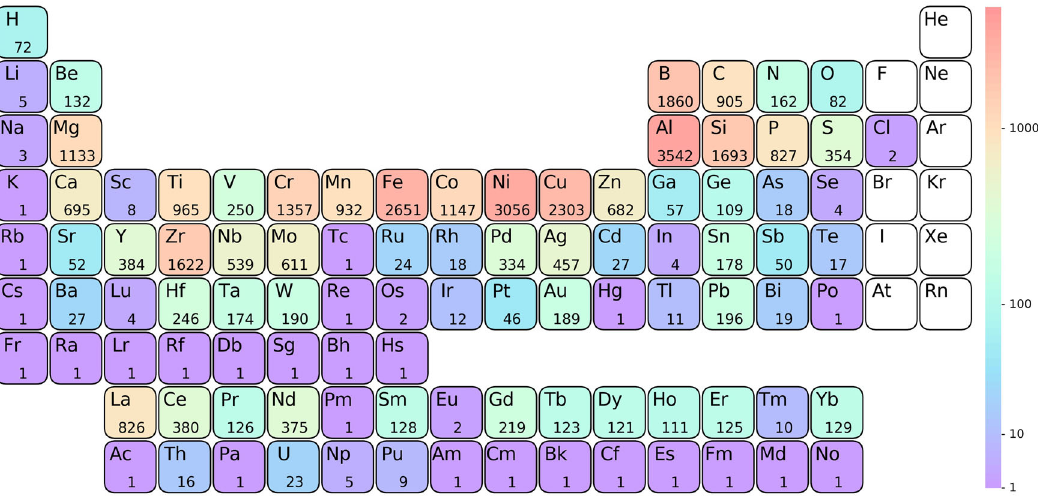
Fig. 2 Statistics of our glass-forming ability dataset. The occurrence numbers of elements in the dataset are given under periodic table background. The blank squares, e.g., squares for noble gases, indicate the elements not in the dataset. Table 1. Comparison of average accuracy among different models under 10-fold cross-validation.